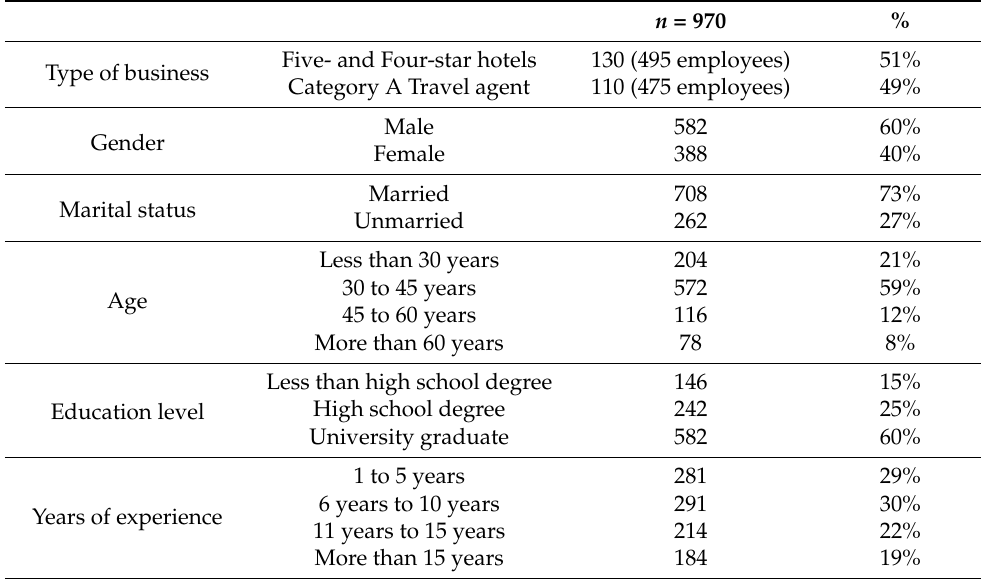
Table 1. Respondents’